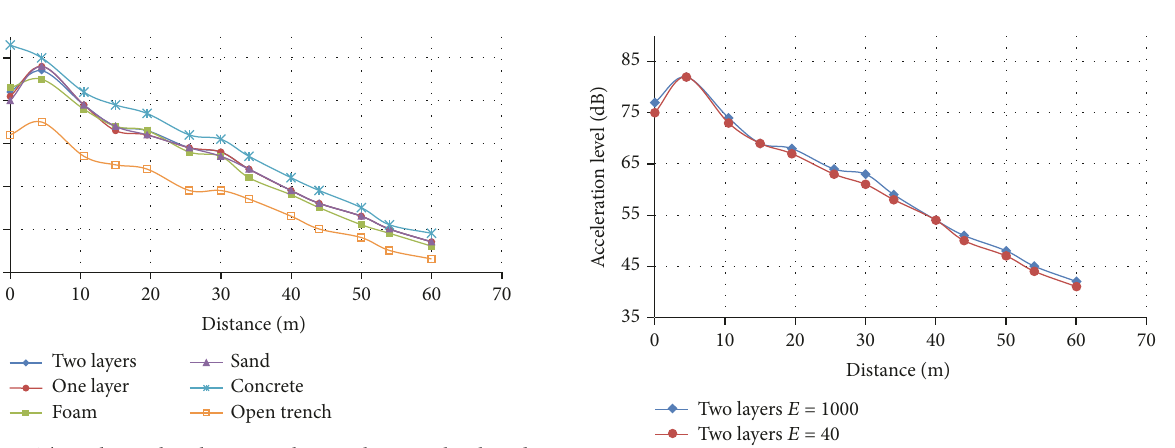
Figure 11: The relationship between the acceleration level and distance under case 6 .